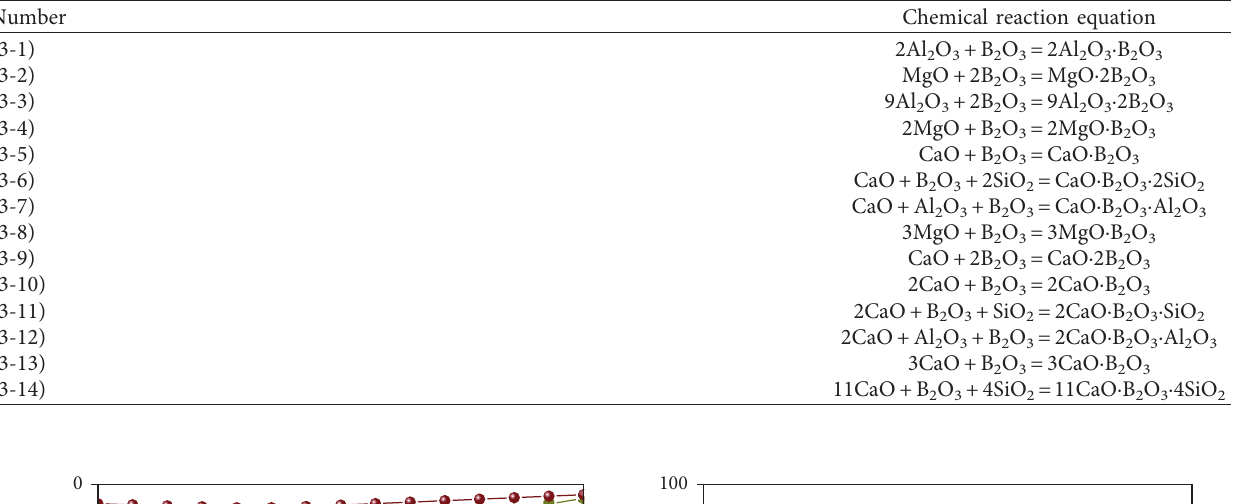
Table 4: Main reactions of B